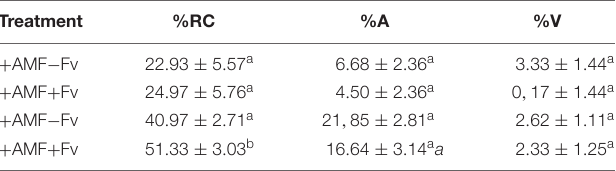
TABLE 1 | Root colonization of soybean plants plated on actively growing extraradical mycelium networks of Rhizophagus irregularis in presence ( + AMF + Fv) or absence ( + AMF − Fv) of the pathogen Fusarium virguliforme .